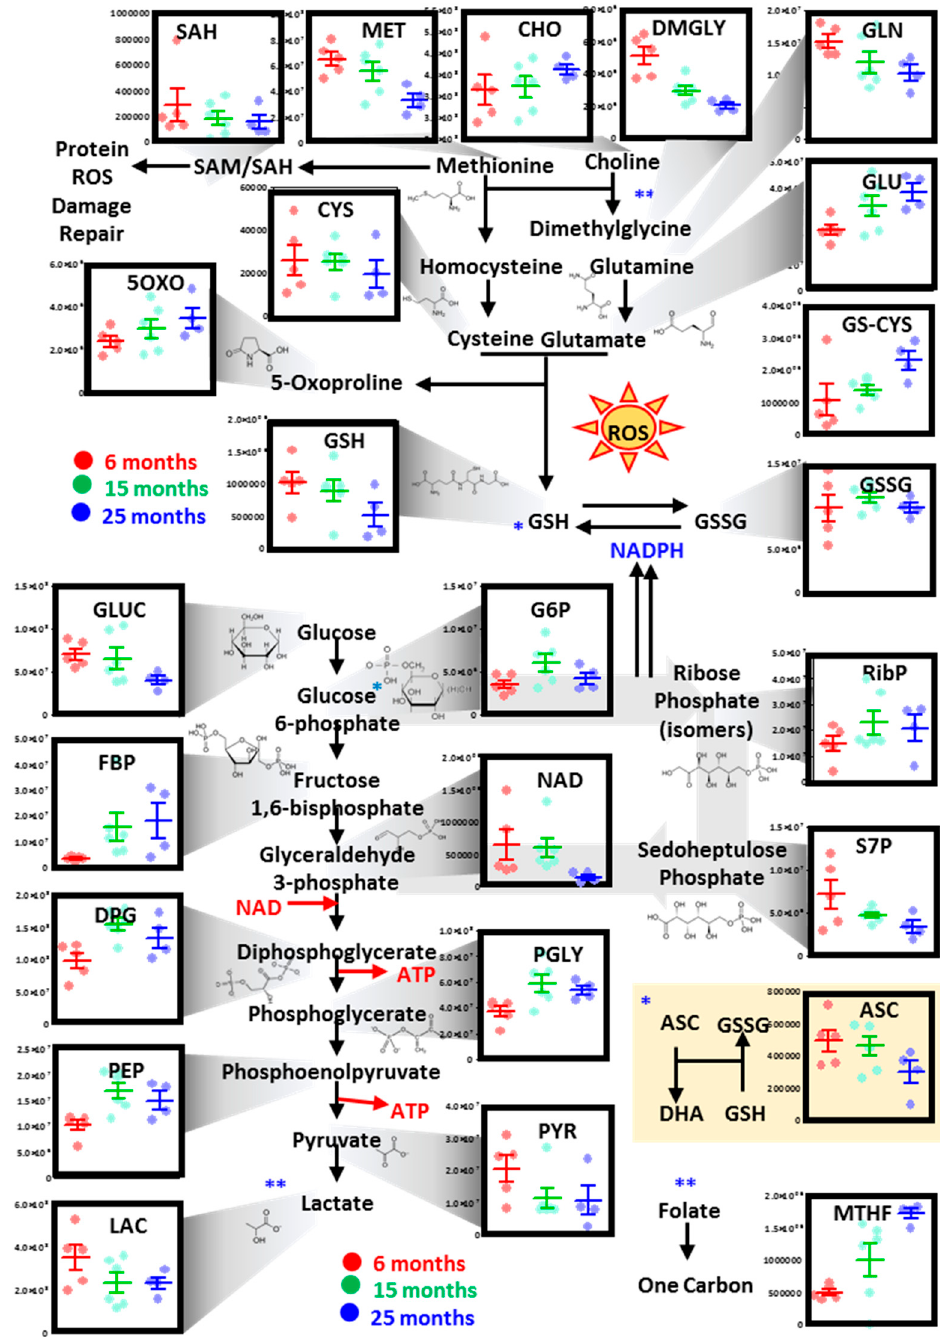
Figure 2. Alterations of RBC glycolysis, the pentose phosphate pathway, and glutathione and one-carbon metabolism as a function of the age of the mouse. Dots represent distinct biological replicates for six- (red), 15- (green), and 25-month-old mice (blue). * cross-talk between glutathione homeostasis and glyoxylate pathway. ** cross-talk between methionine and one-carbon metabolism.